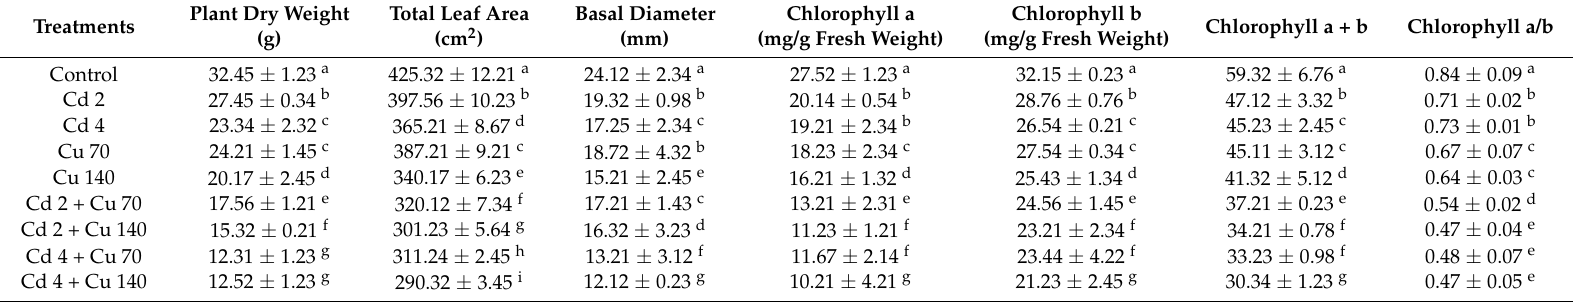
Table 1. Plant dry weight, total leaf area, basal diameter, chlorophyll properties of Gynura procumbens to different cadmium and copper treatments. Treatments